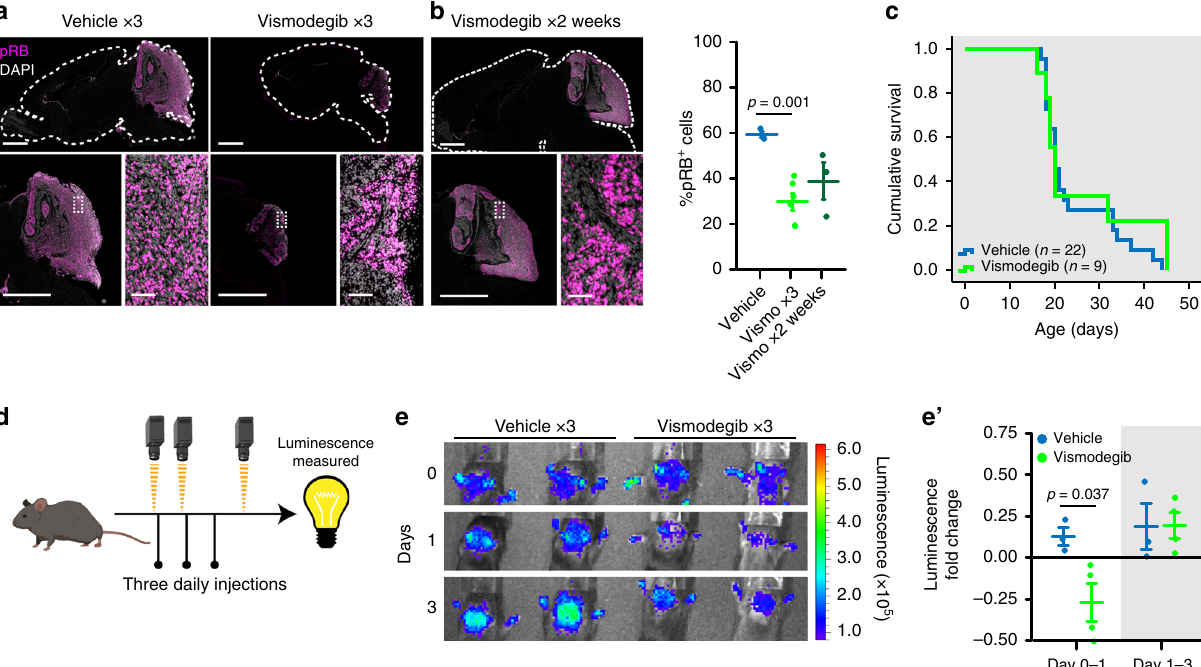
Fig. 1 Vismodegib induces initial tumor response followed by rapid recurrence. a , b Medulloblastoma in sagittal hindbrain sections stained for pRB, from representative a P15 M-Smo mice, treated with three daily doses of vehicle or vismodegib, or b P25 M-Smo mice treated for 2 weeks with vismodegib, and quanti fi cation of pRB + fraction in the indicated groups. c Kaplan – Meier curve comparing survival of M-Smo mice treated with vismodegib or vehicle. d Schematic showing the timing of luciferase imaging and vismodegib administration. e Luciferase signal driven by Gli-luc at indicated times. e ′ Luminescence fold change over the indicated intervals in replicate vismodegib-treated and control mice. Each dot represents the value for a speci fi c replicate animal. Horizontal lines indicate the means, and error bars indicate SEM. p Values determined by two-sided Student ’ s t -test. Scale bars = 2 mm, except in insets, where scale bars = 50 µ